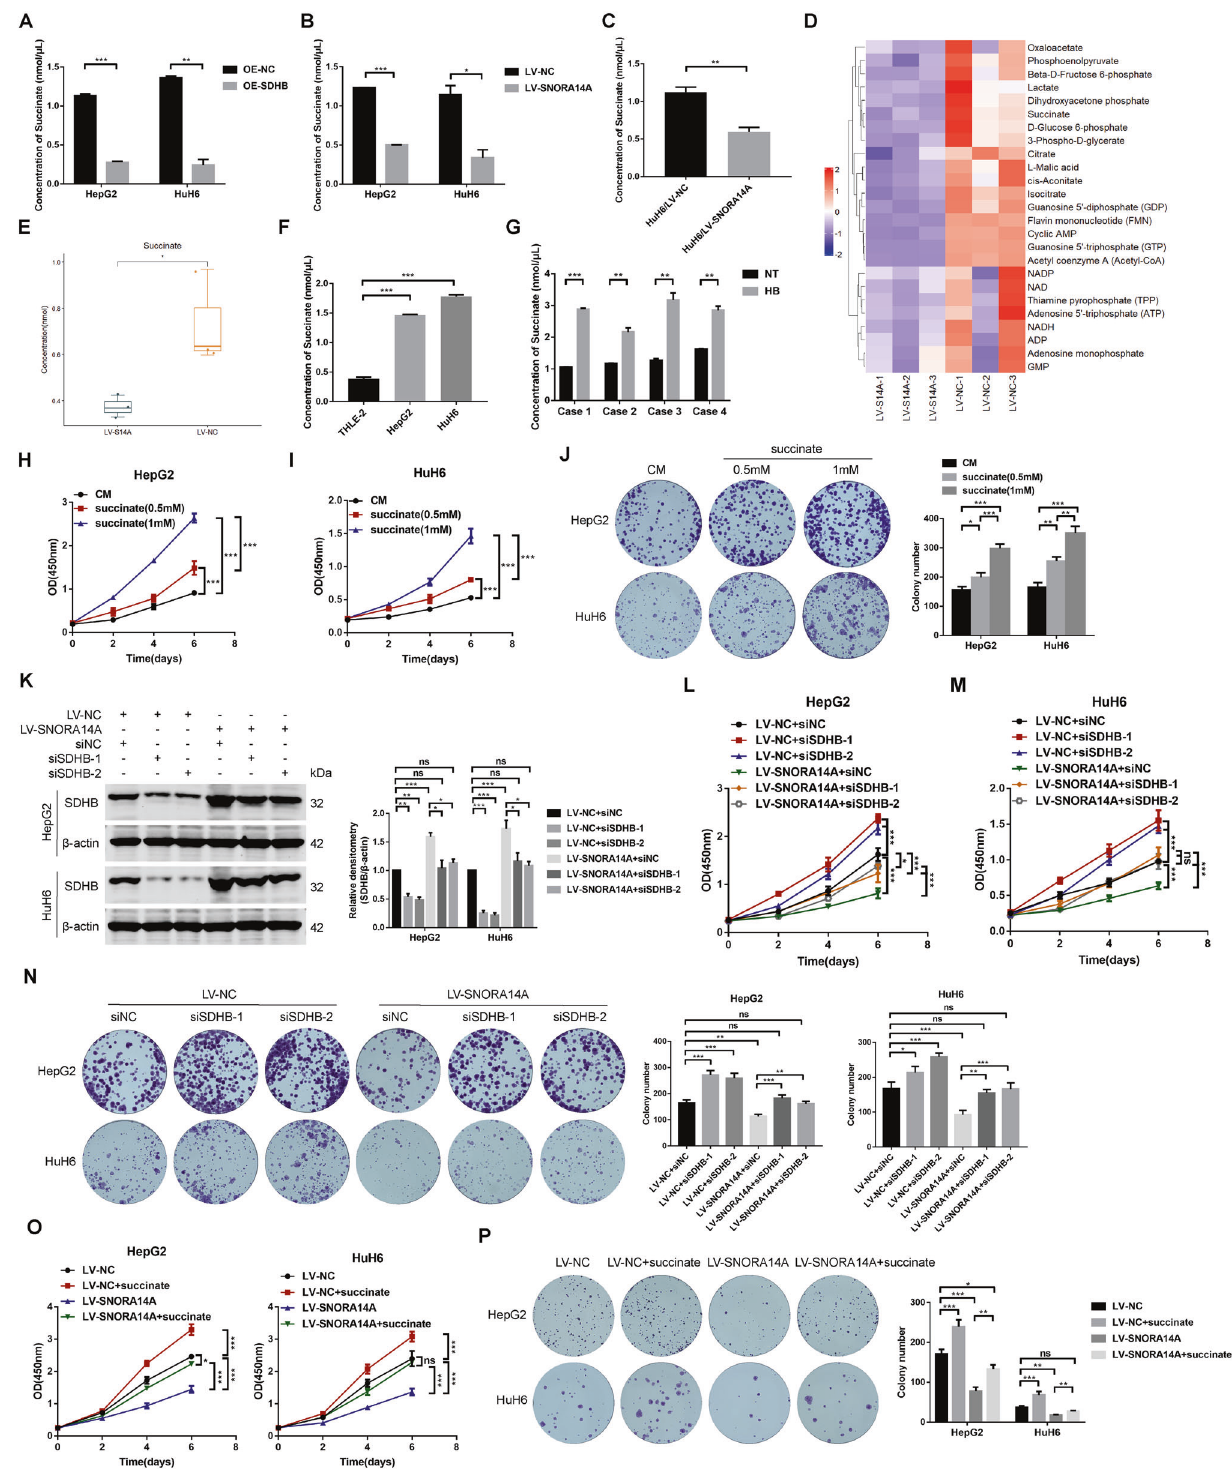
Fig. 8 Tumour-suppressive SNORA14A functions by increasing SDHB protein levels and inhibiting accumulation of the oncometabolite succinate in HB cells. A – C The succinate concentration in HB cells transfected with OE-NC or OE-SDHB plasmids ( A ), stable HB cells ( B ) or tumour xenografts ( C ) was measured by colorimetric assays. D Heatmap clustering of targeted metabolomics conducted in stable HuH6 cells. E The succinate concentration in stable HuH6 cells was measured by targeted metabolomics. F , G Succinate concentrations in cells ( F ) or 4 paired HB and NT tissues ( G ) were measured by colorimetric assays. H – J The proliferative activity of HB cells treated with the indicated concentration of succinate was detected by CCK-8 ( H , I ) and colony formation ( J ) assays. K SDHB protein levels in stable HB cells transfected with siNC or siSDHB-1/-2 were measured by Western blotting assays. Relative densitometry was performed with ImageJ. L – N The proliferative activity of stable HB cells transfected with siNC or siSDHB-1/-2 was detected by CCK-8 ( L , M ) and colony formation ( N ) assays. O , P The proliferative activity of stable HB cells supplemented with succinate was detected by CCK-8 ( O ) and colony formation ( P ) assays.